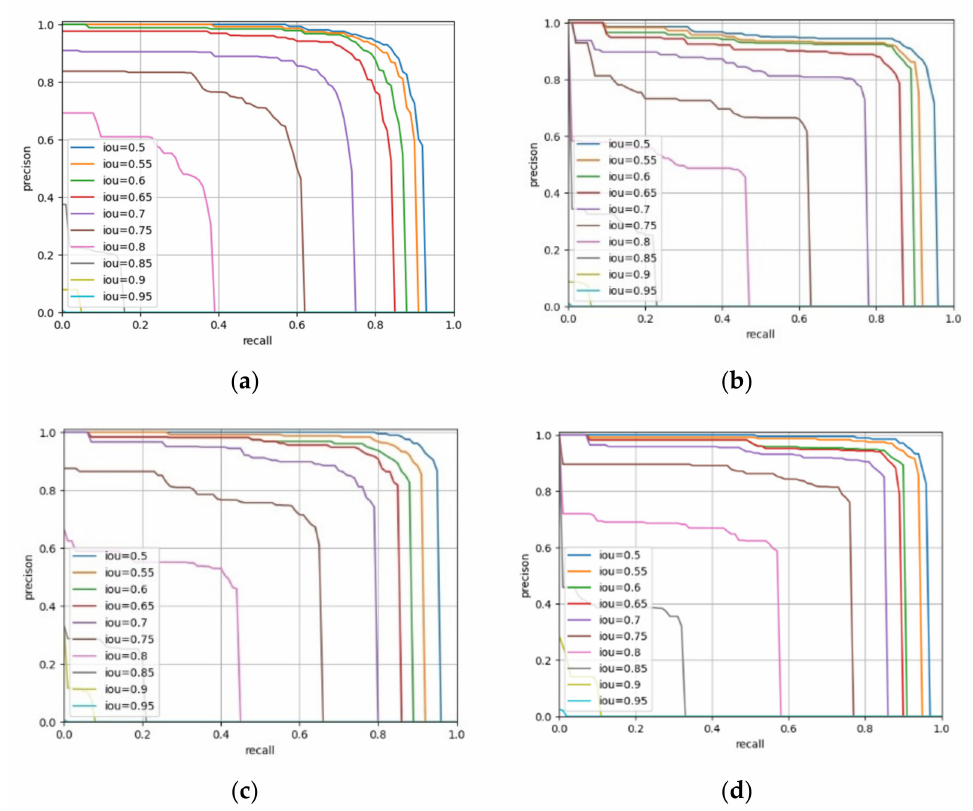
Figure 12. The PR curves of the original Faster-RCNN algorithm constructed using different fea- ture extraction networks: ( a ) the PR curve of the VGG16 feature extraction network experiment; ( b ) the PR curve of the ResNet50 feature extraction network experiment; ( c ) the PR curve of the ResNet101 feature extraction network experiment; ( d ) the PR curve of the HRNet feature extraction network experiment.